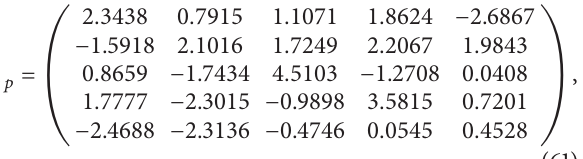
which satisfies the relationship 𝐴 𝑝 = 𝑃 to solve the eigenpairs of matrix 𝐴 , we have to calculate the eigenpairs of the matrix 𝐴 𝑝 at first. Direct